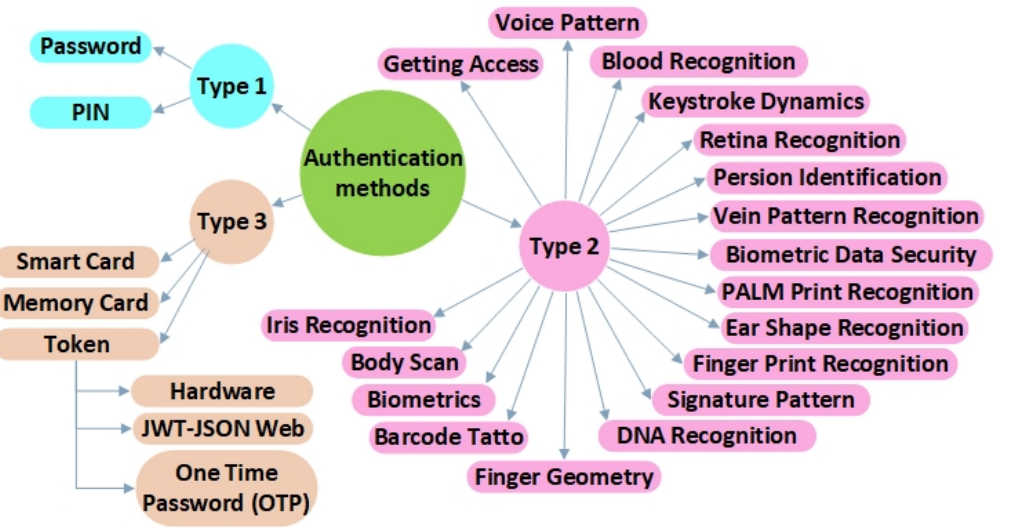
Figure 2. Three main types of authentication methods.